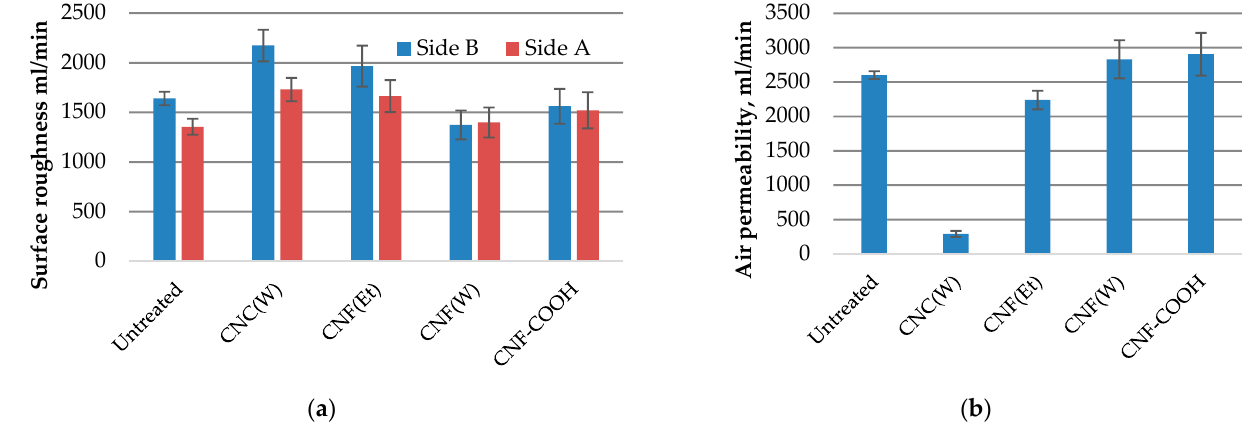
Figure 8. Surface roughness ( a ) and air permeability ( b ) of WBP treated with different preparations of CN.